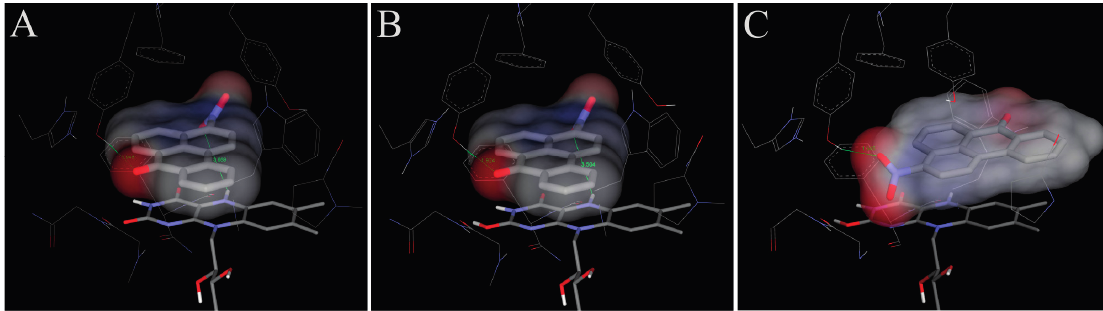
Figure 4. The binding orientations resulting from molecular docking calculations enabling the hydrogen transfer from N5 of isoalloxazine ring of FAD to the nitro group of 3-NBA ( A , B ) are shown docked to the active site of human NQO1. The two possible forms of reduced isoalloxazine ring—ionized enolate and protonated enol—bound to the NQO1 active site are labeled with subscript A and B, respectively. Binding orientations favoring a proposed alternative three-step (e − , H + , e − ) reduction is labeled as ( C ). The 3-NBA ligand is positioned parallel to the flavin prosthetic group. FAD cofactor and amino acids residues within 5.5 Å from ligand are rendered as bold sticks, and sticks and lines, respectively. Panels A and B are taken from [52].